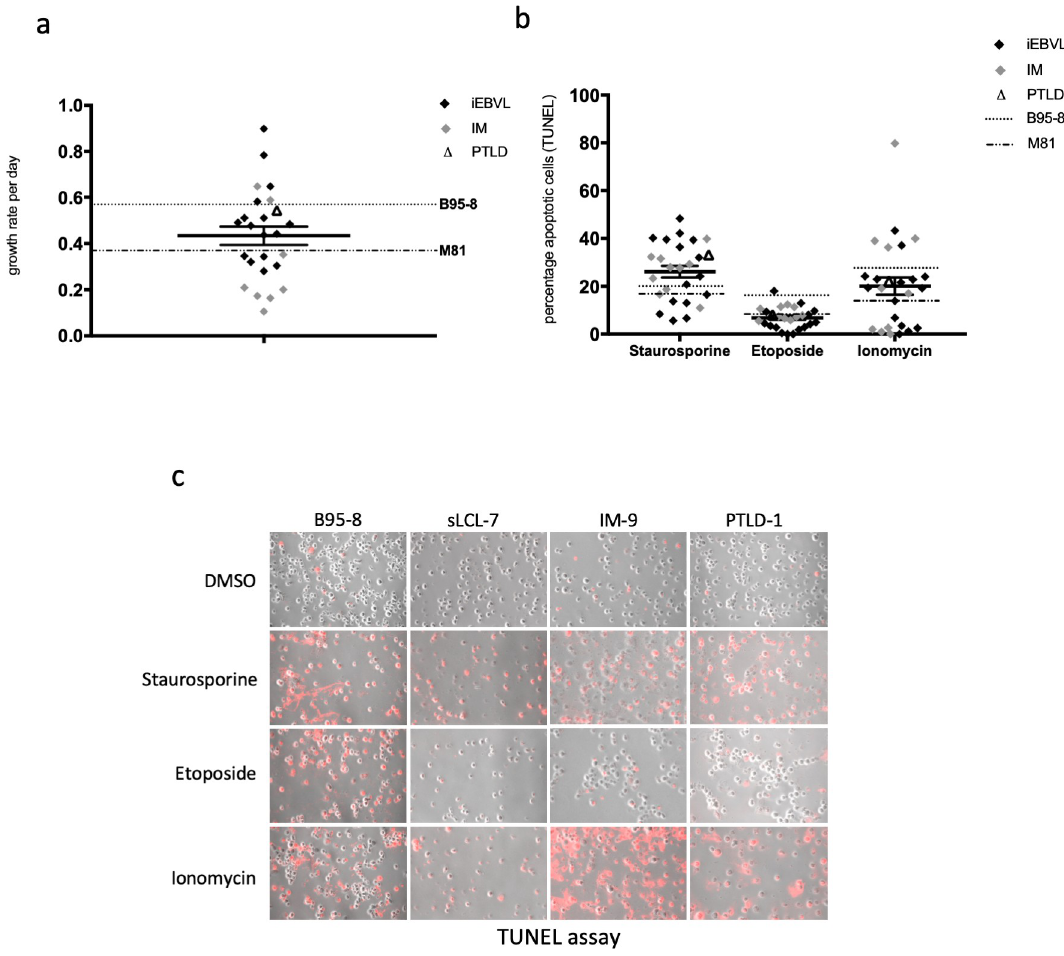
Fig 1. The cell growth rate and resistance to apoptosis vary widely across a panel of EBV-transformed B-cells isolated from patients with an increased EBV load after transplantation or from IM patients. (a) We seeded infected B-cells from transplanted patients with increased EBV load (iEBVL) or PTLD and from IM patients under optimal growth conditions and calculated their growth rate per day. We monitored in parallel the growth of B-cells from a blood sample infected with either B95-8 or M81, two viruses known to induce rapid and slow cell growth, respectively. The dot plot shows the growth rate per day of each sample. We also indicate the mean of these values and their standard error. (b) Apoptosis was induced in the same panel of B-cells using three different drugs. The percentage of apoptotic cells in each case was determined by a TUNEL assay. The results of the assays are summarized in three dot plots. (c) Examples of stains with the TUNEL assay are shown.